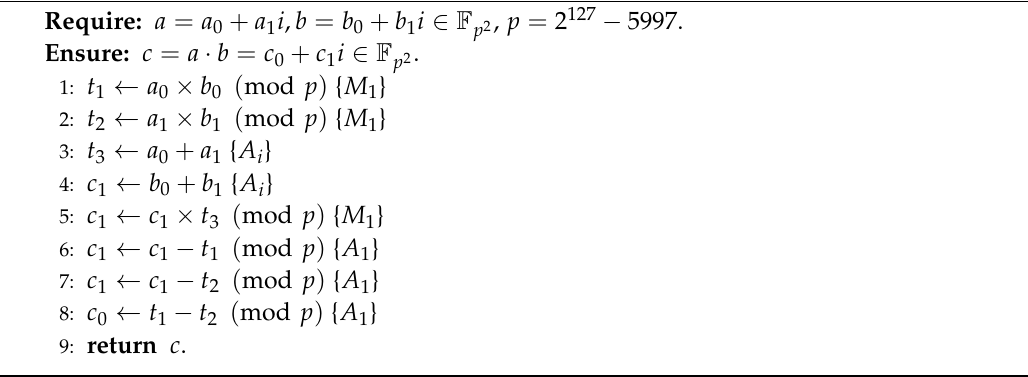
Algorithm 3: Field squaring over F